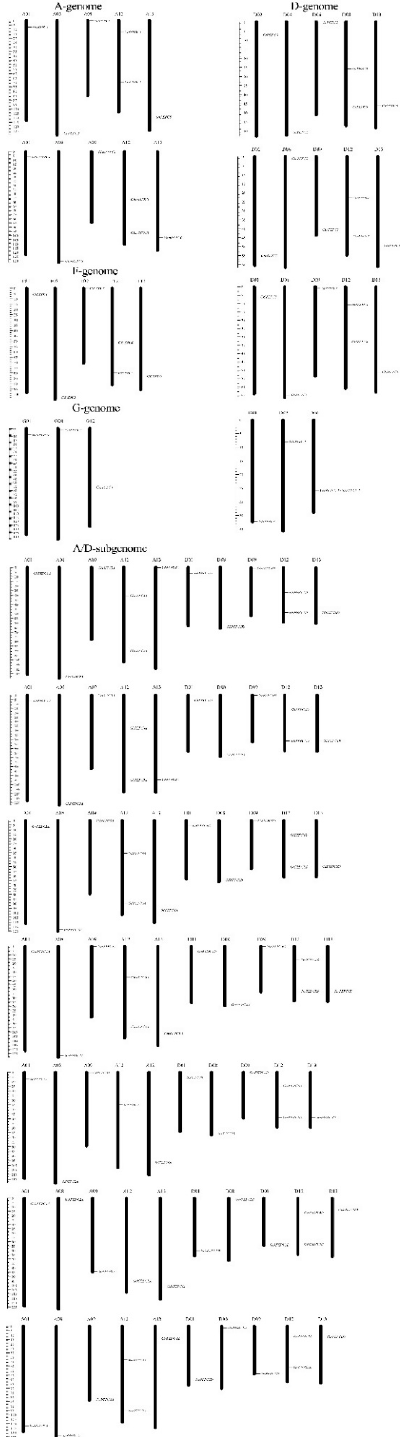
Figure 5. Distribution of the PEPC genes on the cotton chromosomes. The vertical bar located on the left side indicates the chromosome sizes in mega bases (Mb), the chromosome number is located above each chromosome.